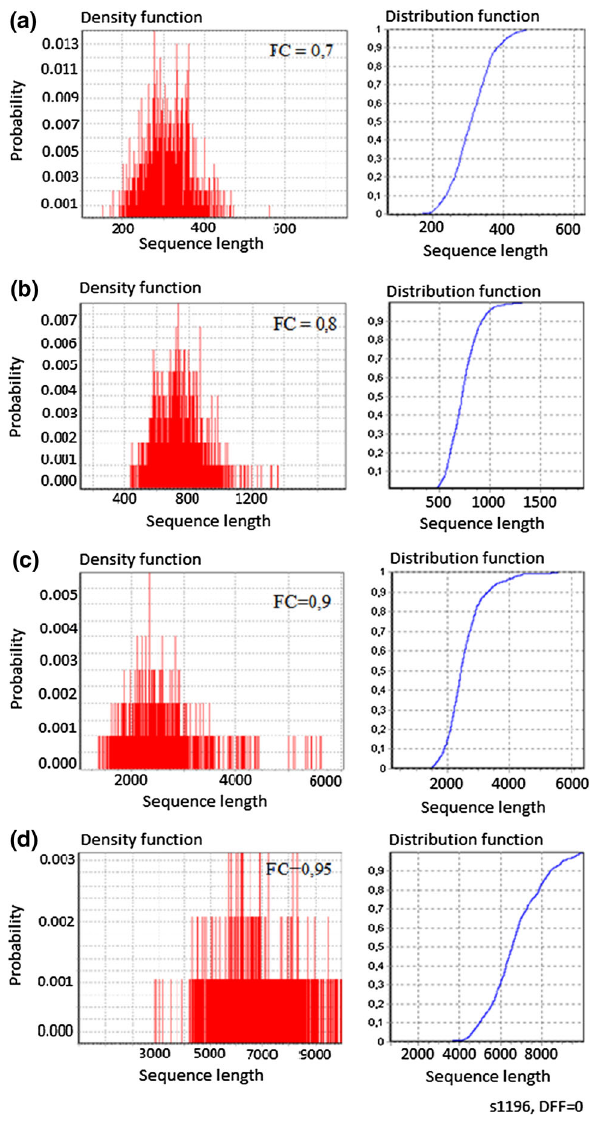
Fig. 20 s1196 density and distribution function that reached a FC